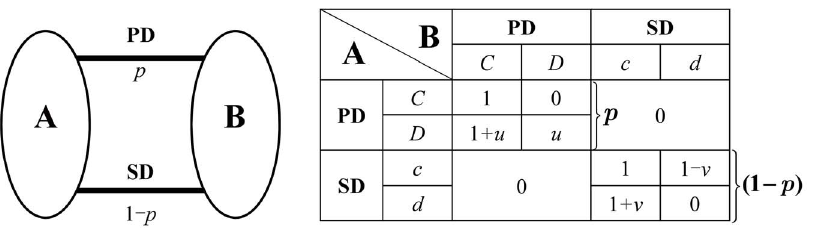
Figure 1. Multiple roles game(MRG) model with PD and SD. There are two interaction channels between individual A and B. The channel PD has a probability p to be selected and the channel SD has a probability 1 { p to be selected.